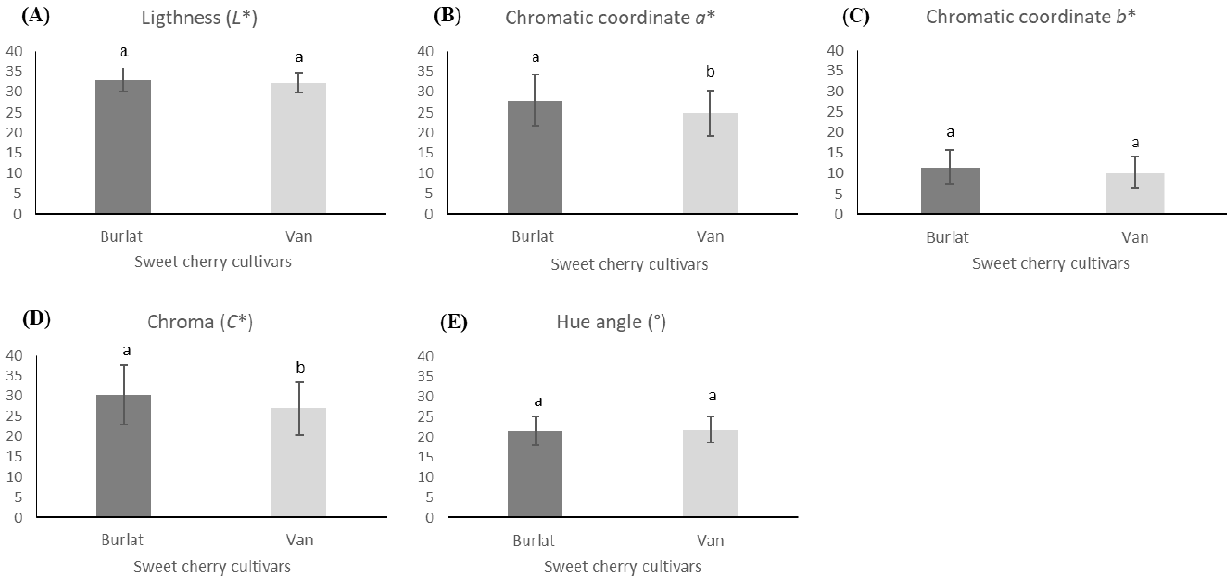
Figure 3. Chromatic parameters of the two sweet cherries cultivars (Van and Burlat): ( A ) Lightness ( L* ); ( B ) Chromatic coordinate a *; ( C ) Chromatic coordinate b *; ( D ) Chroma ( C *) and ( E ) Hue angle (°). The presented values resulted from the mean ± SD ( n = 60). Statistically significant differences between cultivars, for each parameter, were represented by different letters (ANOVA-Tukey’s test, p < 0.05).